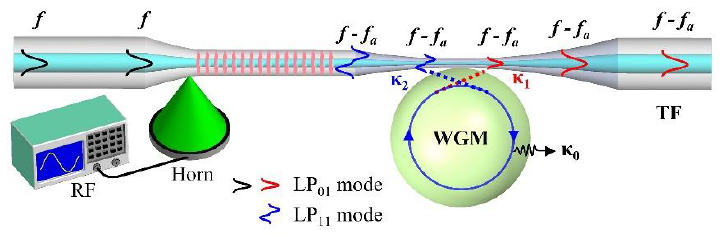
Figure 1. The structure of the proposed all-fiber AOFS. κ 1 and κ 2 are the coupling loss to the LP 01 mode and the LP 11 mode of the WGM, respectively, and κ 0 is the intrinsic loss of the WGM. The evolution of the signal light’s frequency is also presented in the